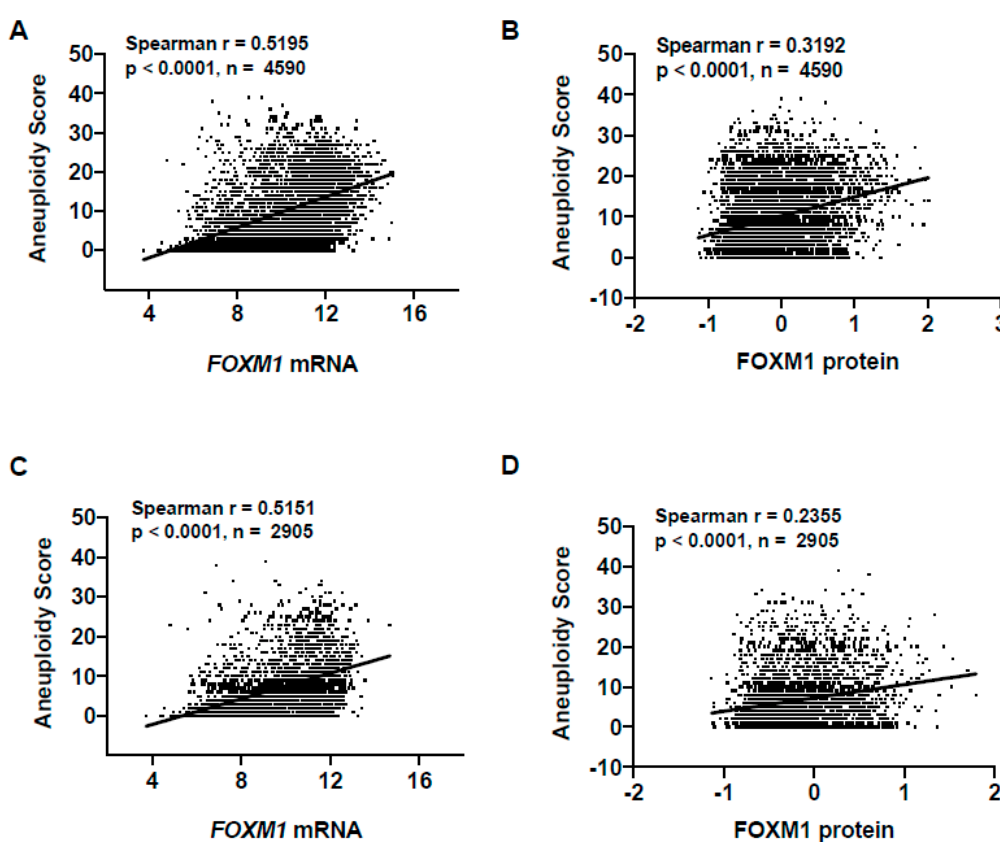
Figure 3. Association of FOXM1 expression with aneuploidy in TCGA pan-cancer. ( A ) FOXM1 mRNA expression (RNA-seq RSEM, log2(norm count +1)) correlations with tumor aneuploidy scores in TCGA primary tumors. ( B ) FOXM1 protein expression (RPPA, pan-can normalized) correlation with tumor aneuploidy score in TCGA primary tumors. ( C ) FOXM1 mRNA expression (RNA-seq RSEM, log2(norm count +1)) correlation with tumor aneuploidy score in FOXM1 diploid TCGA primary tumors. ( D ) FOXM1 protein expression (RPPA, pan-can normalized) correlations with tumor aneuploidy scores in FOXM1 diploid TCGA primary tumors.